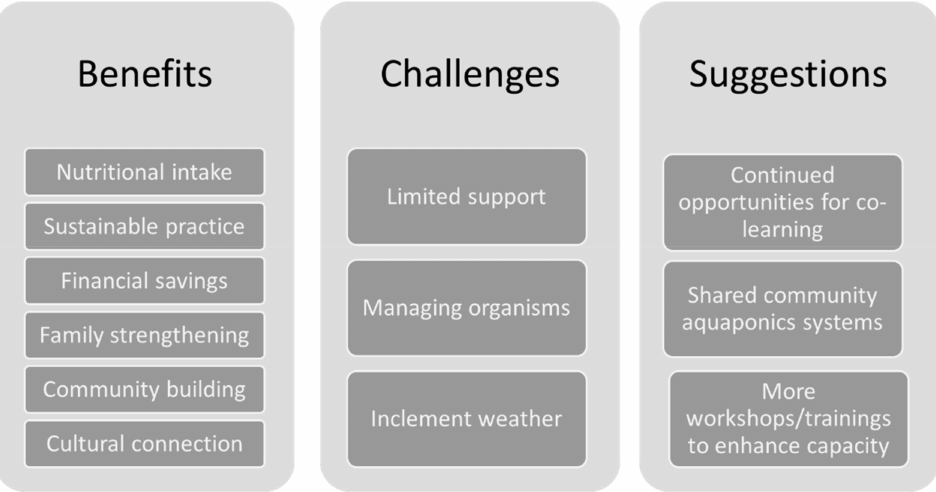
Figure 2. Themes from Waim¯analo aquaponics